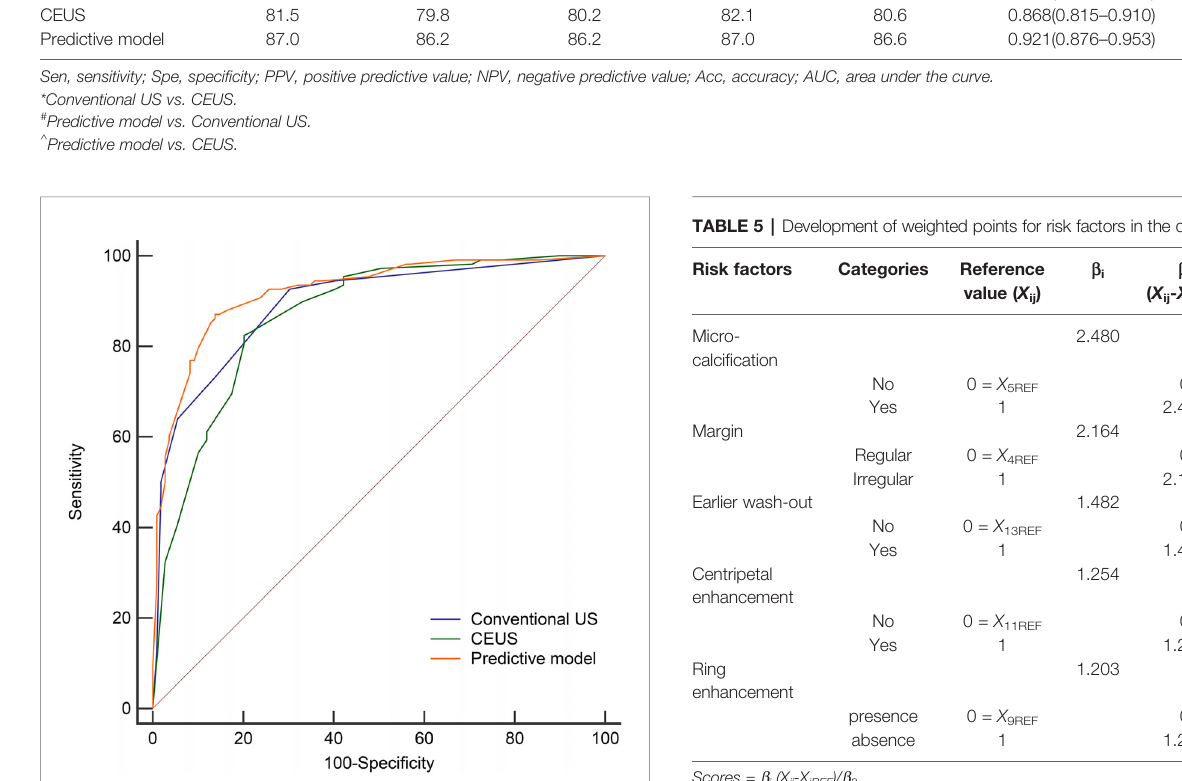
the derivation cohort.